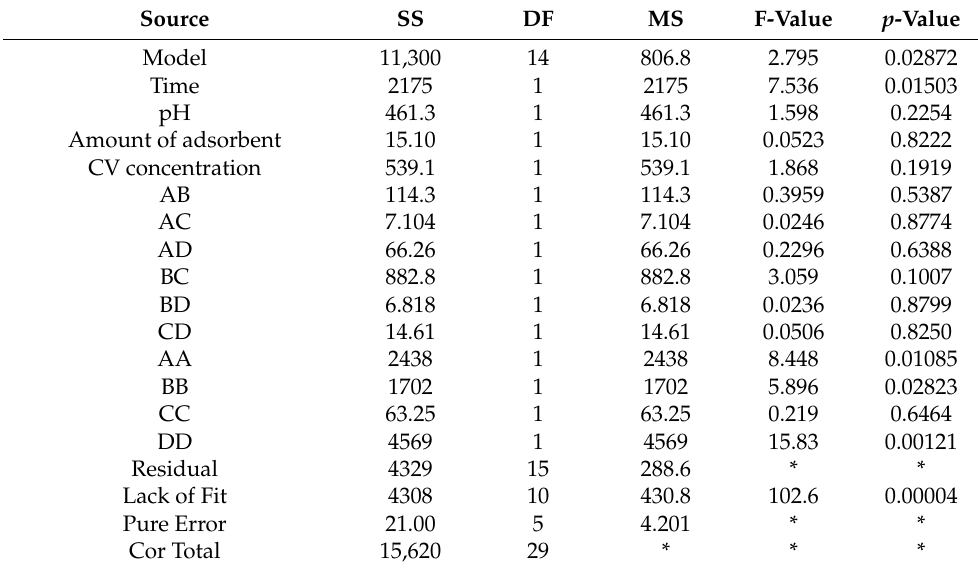
Table 2. ANOVA for the decontamination of CV dye from aqueous medium by the IZNC. Source